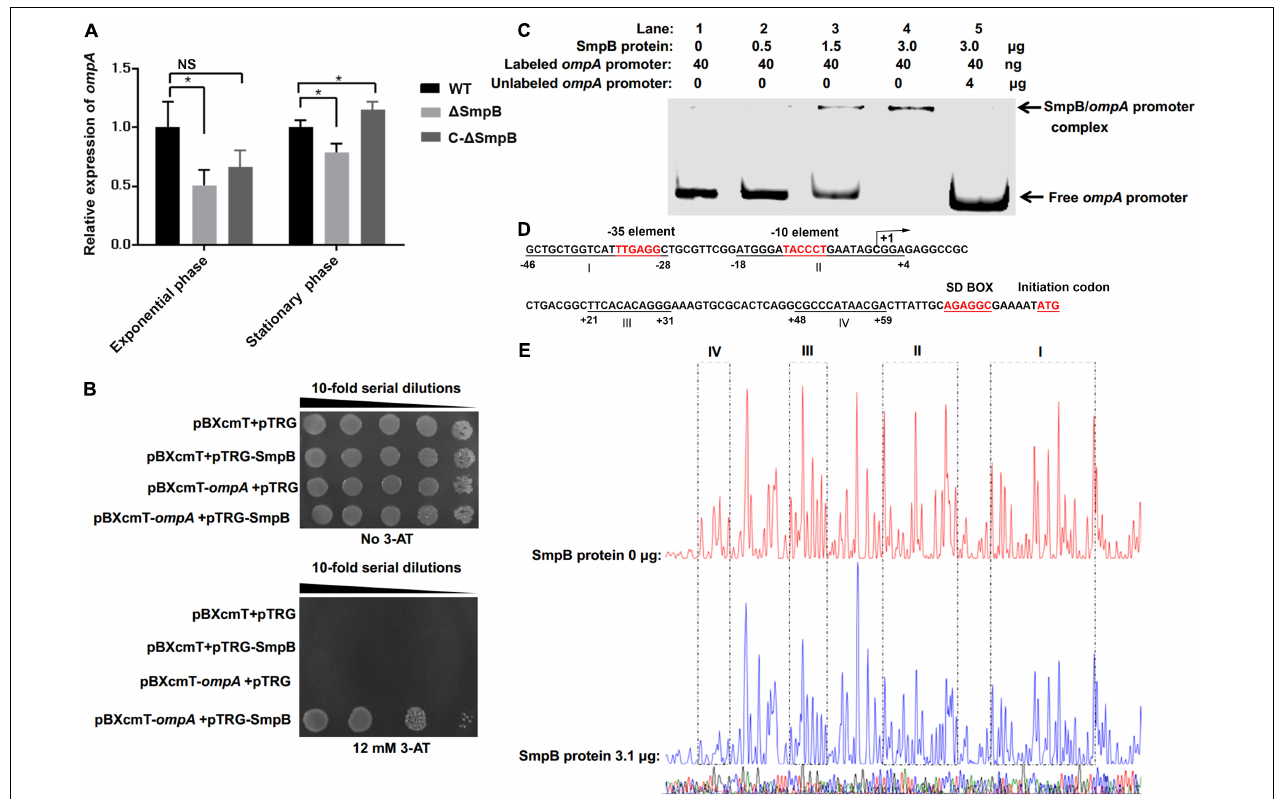
FIGURE 1 | Identification of the key region in the predicted ompA promoter (P ompA ) interacting with small protein B (SmpB). (A) Quantitative real-time PCR (qPCR) assays. The relative expression of ompA was analyzed in WT, (cid:49) SmpB, and C- (cid:49) SmpB in the exponential and stationary phase, respectively. The NS represents “not statistically significant” and * represents significant differences ( p < 0.01). (B) Verification of SmpB interacting with the P ompA by bacterial one-hybrid system. The interaction between SmpB and the P ompA was monitored by the growth on 3-AT-free and 12 mM 3-AT medium. (C) Binding of SmpB to the P ompA . Electrophoretic mobility shift assay (EMSA) was performed using the purified SmpB with the promoter regions of the ompA gene. The DNA segments were amplified from the promoter of the predicted ompA gene. (D) The DNA sequences of the protected regions were provided, and the sequences were underlined. Transcriptional start site was marked with an arrow. Nucleotide sequences were numbered considering the transcription initiation site as +1. (E) Identification of SmpB-protected DNA fragments in the promoter regions of ompA using DNase I footprinting assays. The regions protected by SmpB were marked with frames of dashed